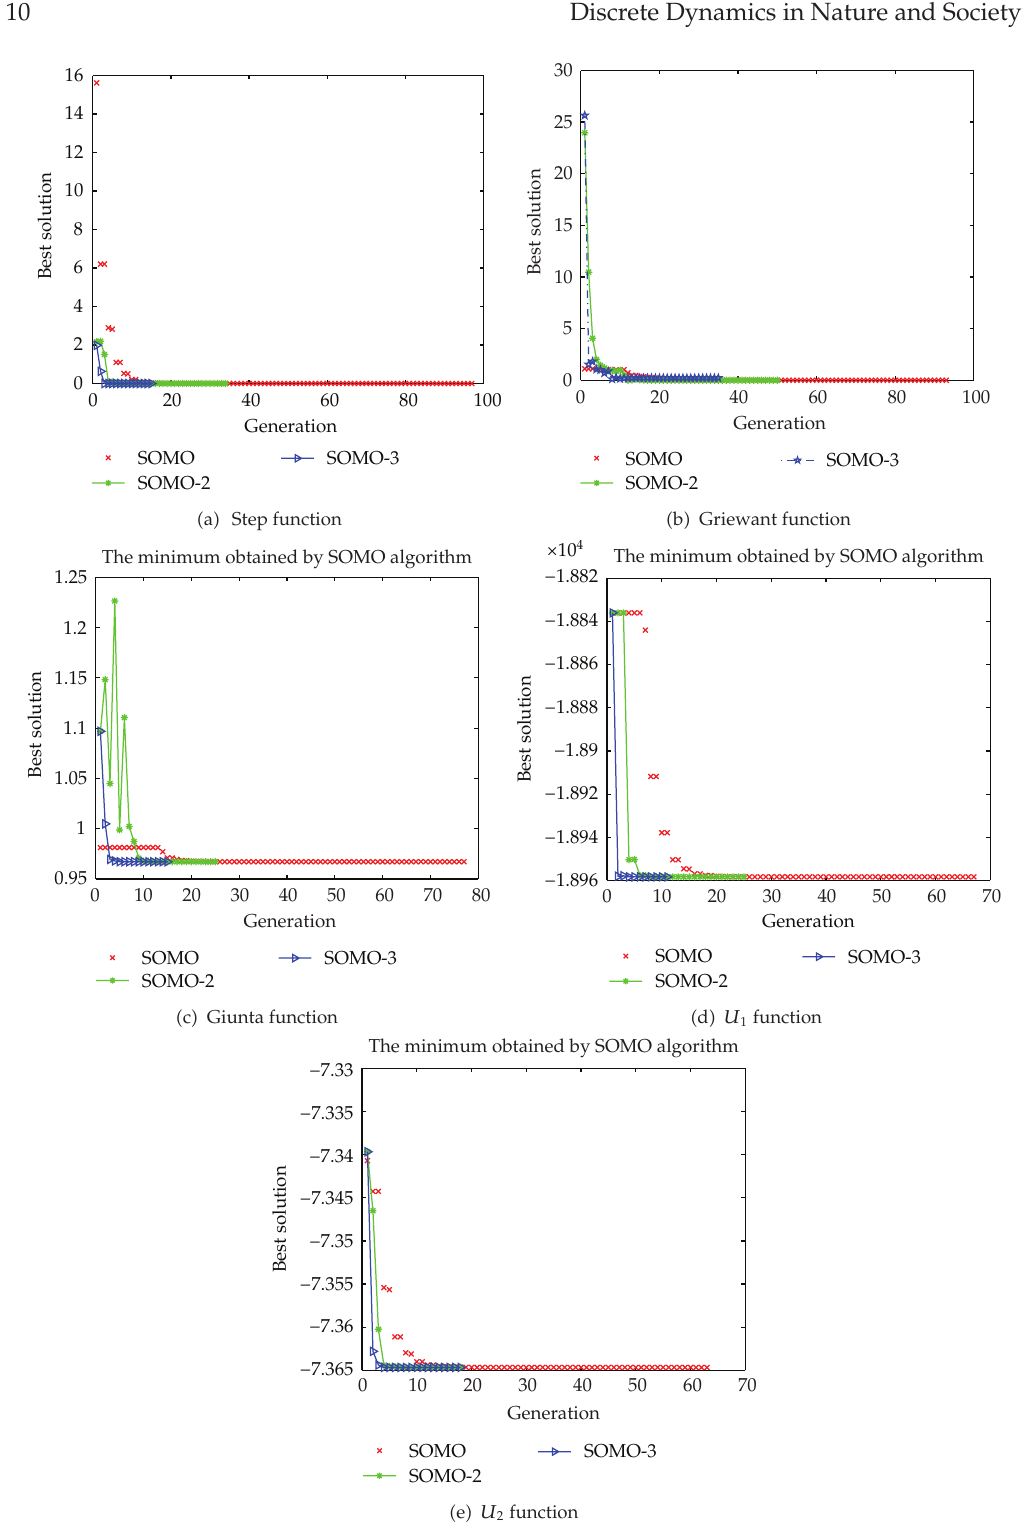
Figure 2: Best performance curves for SOMO, SOMO-2, and SOMO-3 algorithms,